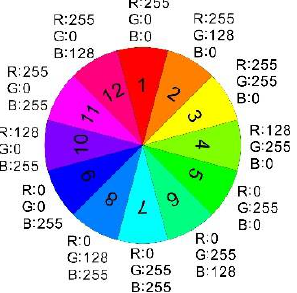
Figure 7. Building damage assessment map. ( a ) Damage assessment map obtained by coherent change detection; ( b ) Overlay of Figure 5a based on optical image obtained using Google Earth Engine (https://earthengine.google.com/), and accessed on 10 October 2021.